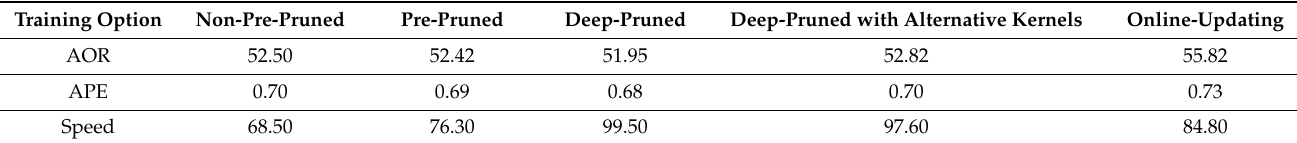
Table 5. Comparison of all experimental